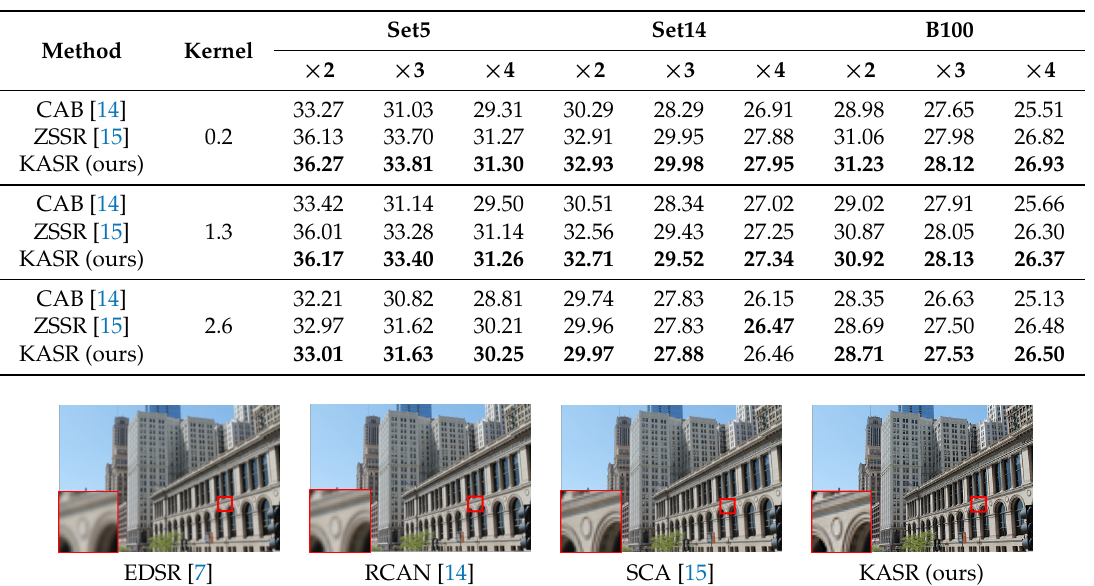
Table 1. Comparison of SR results (PSNR) for isotropic Gaussian blur kernel cases.